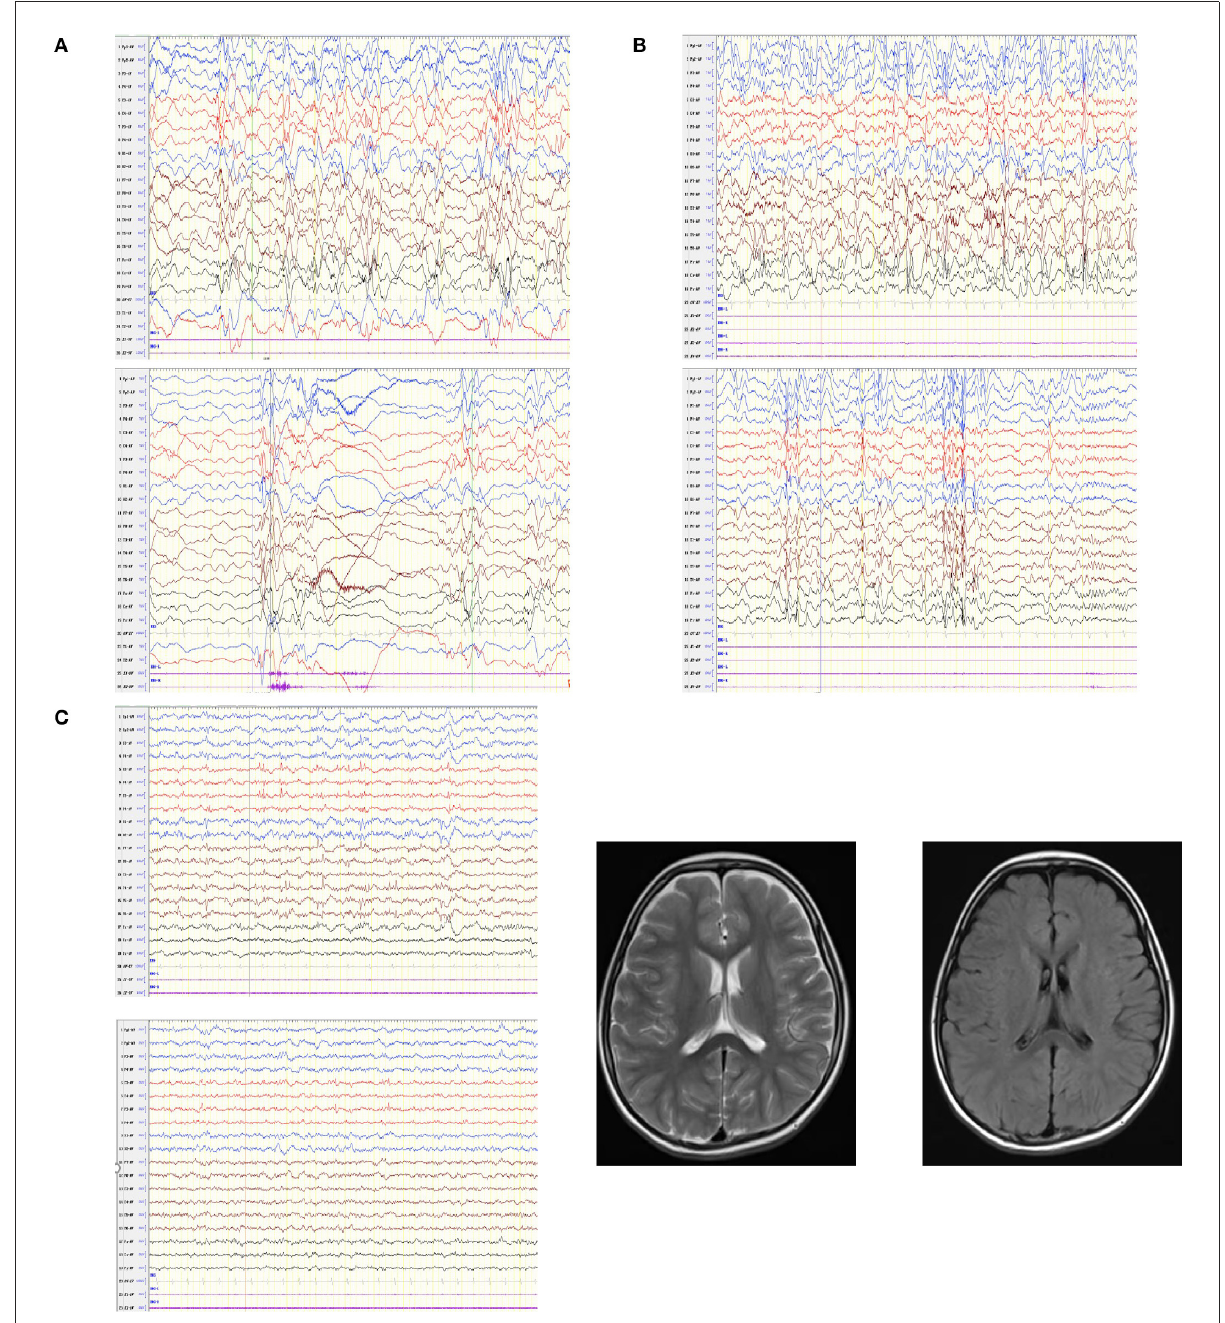
FIGURE2 EEGs in patients with GABRA1 gene pathogenic variants and the MRI of one patient. (A) Case 1: hypsarrhythmia, multiple isolated and cluster or focal convulsive episodes. (B) Case 8: hypsarrhythmia, multifocal spike wave, spike slow wave, and poly-spike slow wave. (C) Case 4: slow background rhythm, spike wave and spike slow complex wave; patient’s MRI was normal.